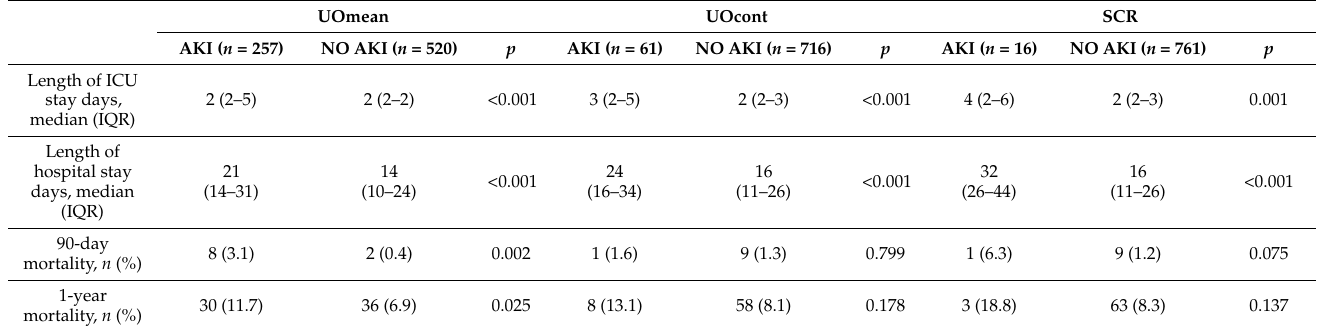
Table 2. The association between AKI and non-AKI patients and clinical outcomes under different criteria.